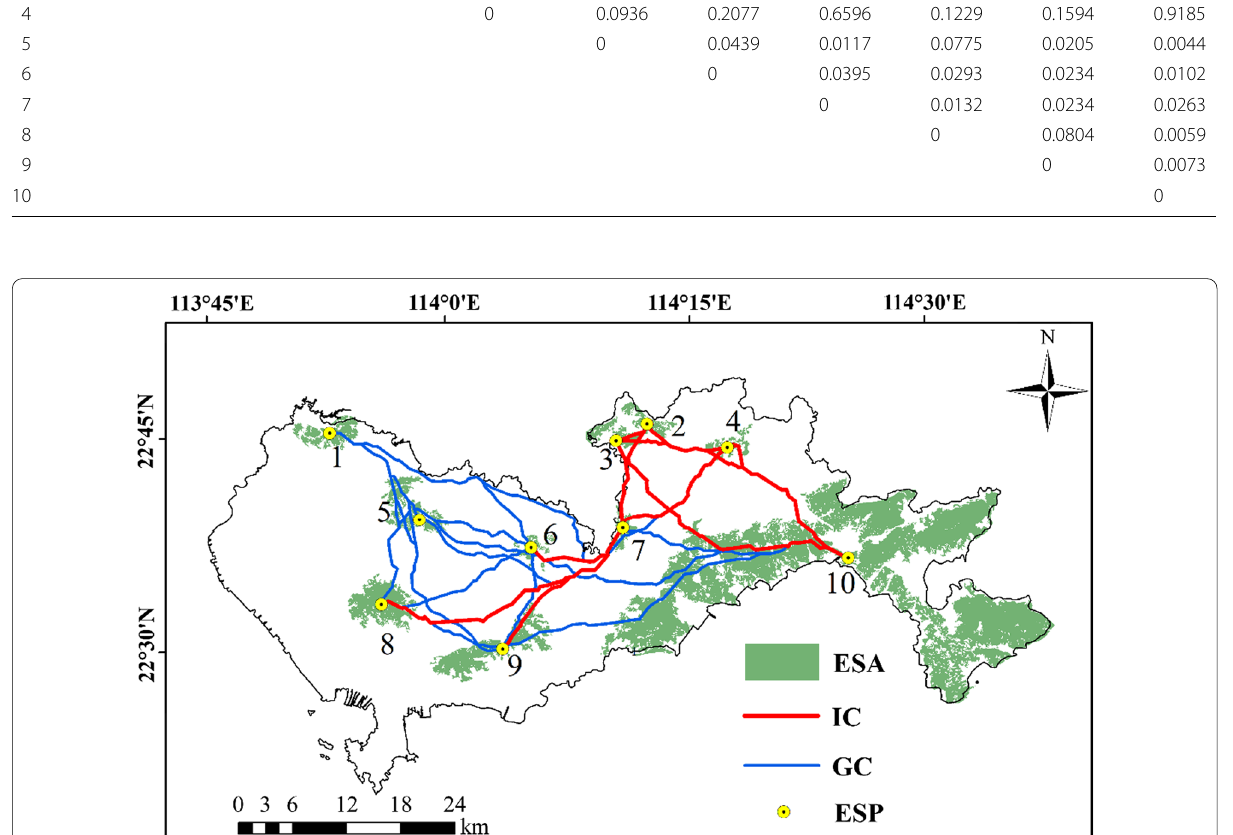
Fig. 6 Distribution of ecological corridors in the study area. Numbers from one to ten mark the locations of the ten ecological source points. ESP ecological source point, IC important corridor, GC general corridor, ESA ecological source